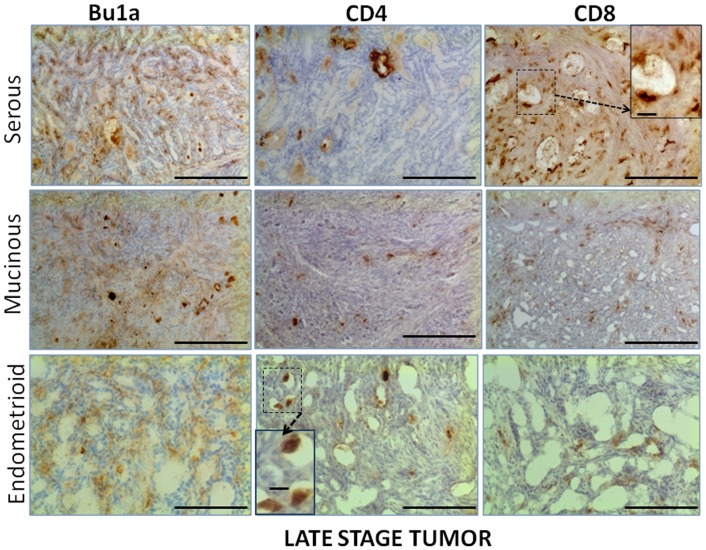
Immune cell distribution in ovaries with late stage ovarian tumors.Similar regions of three tumor types are shown in serial sections stained for Bu1a, CD4 and CD8. Top Row: An example of sections from a serous ovarian tumor showing few CD4+ cells within the tumor compared to Bu1a+ and CD8+ cells. Middle Row: An example from a mucinous ovarian tumor showing deposits of Bu1a+, CD4+ and CD8+ cells between glands and throughout the tumor. Bottom Row: An example of an endometrioid ovarian tumor showing Bu1a+, CD4+ and CD8+ cells. Original magnification, 10x; scale bar = 100 µm. Stained CD8+ and CD4+ lymphocytes in selected areas (dotted boxes) are shown in insets at higher magnification; scale bar = 10 µm.